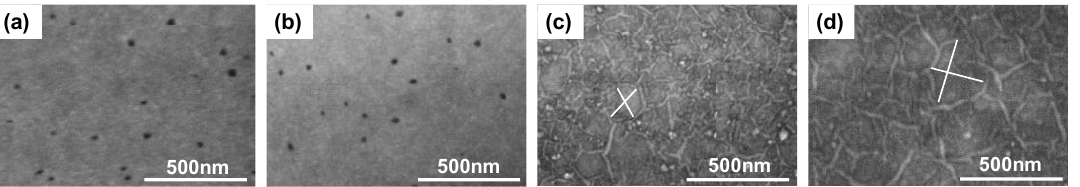
Figure 2. The SEM images of BN films with fixed 150 growth loops under four FME modes: ( a ) NH 3 /TEB, ( b ) NH 3 /Itrp/TEB, ( c ) NH 3 /TEB/Itrp, ( d ) NH 3 /Itrp/TEB/Itrp. White crossed line segments within wrinkled domains in ( c , d ) are used to estimate the wrinkle wavelength.